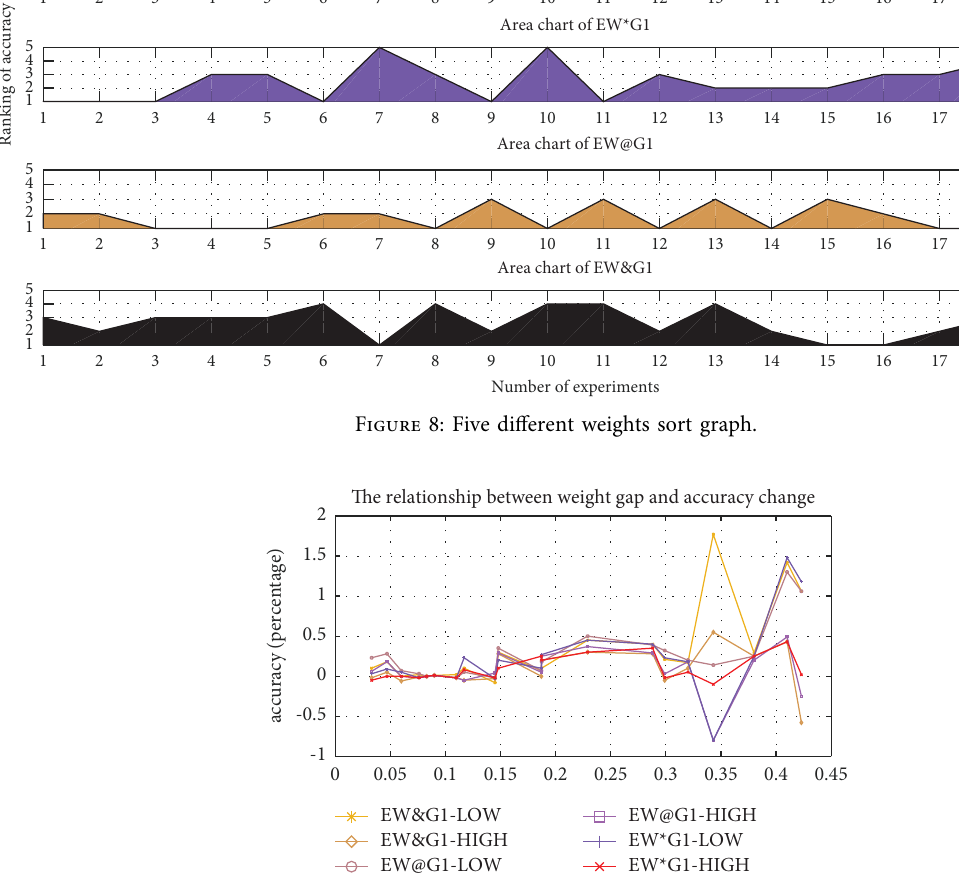
Figure 9: Te relationship between the weight gap and accuracy